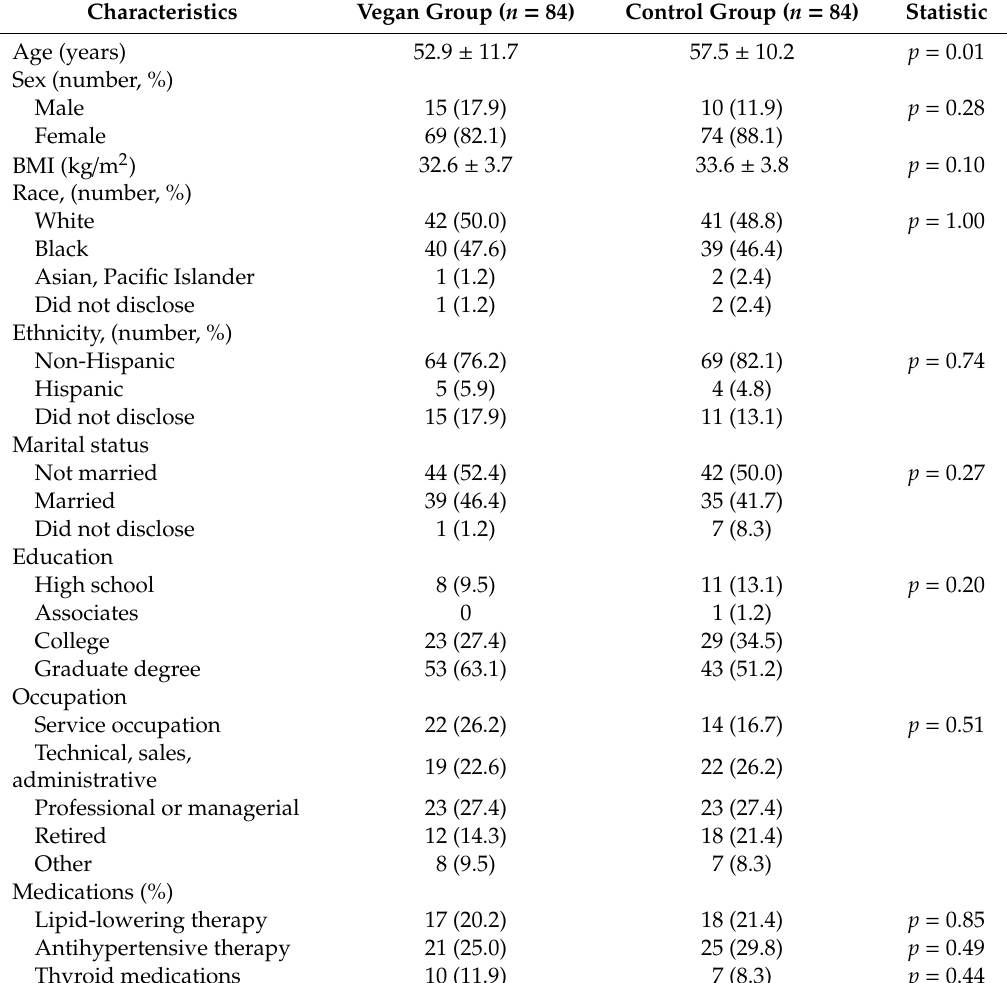
Table 1. Baseline characteristics of the Study